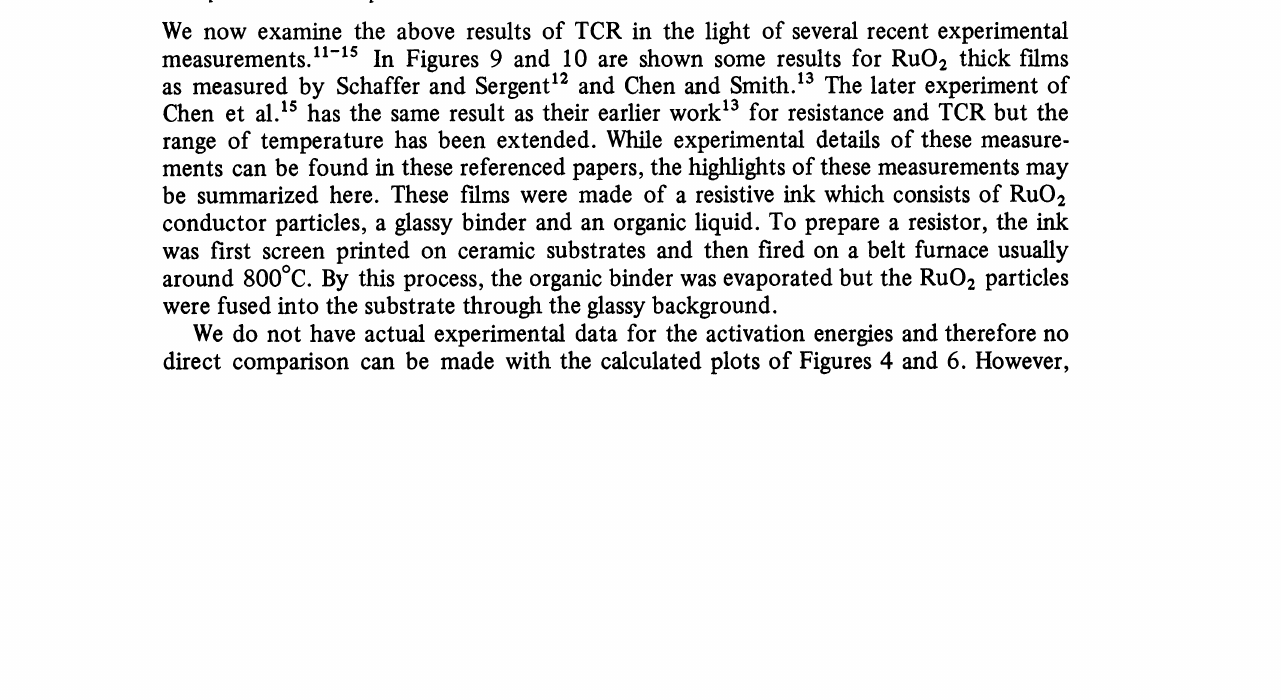
The experimental plots of a for 8% RuO films as measured by Schaffer and Sergent. 12 The dimension of the films were (1) 20 mil. 20 mil., (2) 40 mil. 40 mil., (3) 60 mil. 60 mil., (4) 80 mil. 80 mil. Group and Group II represent particle size of 3.1 and 2.2 t